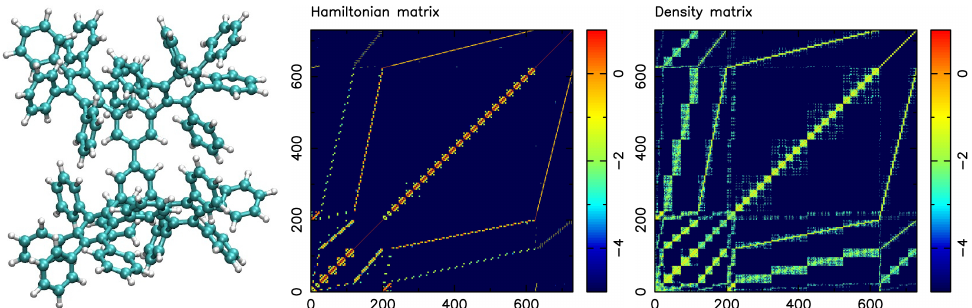
Figure 2. Molecular representation of phenyl dendrimer ( left ) using cyan and white spheres for carbon and hydrogen atoms, respectively. Hamiltonian matrix as 2D representation ( middle ) and thresholded density matrix ( right ). All plots show log 10 of the absolute values of all matrix elements. The SM-SP2 algorithm was used to compute the density matrix. Figure taken from [12]. Copyright c (cid:13) 2016 Society for Industrial and Applied Mathematics. Reprinted with permission. All rights